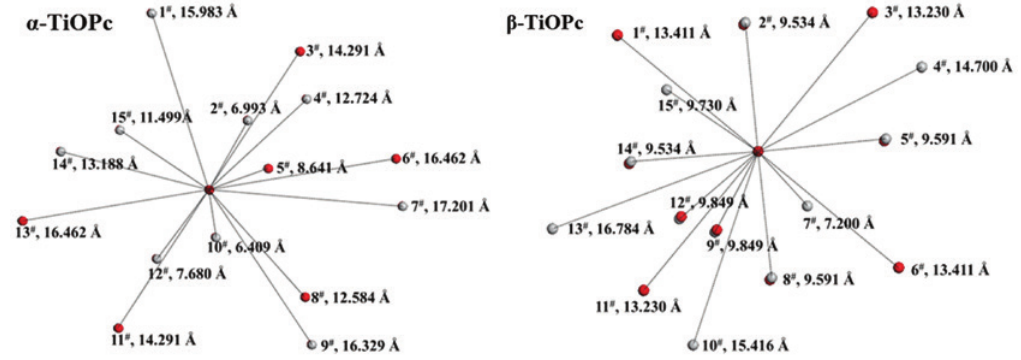
Figure 8: The charge transfer routes in the crystal structures of the α -TiOPc and β -TiOPc. The red ball represents the oxygen atom of the TiOPc molecule facing outward, and the gray ball represents the oxygen atom facing